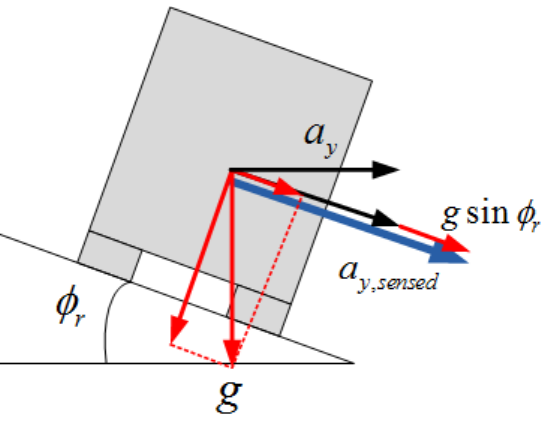
Figure 3. Vehicle vertical model.